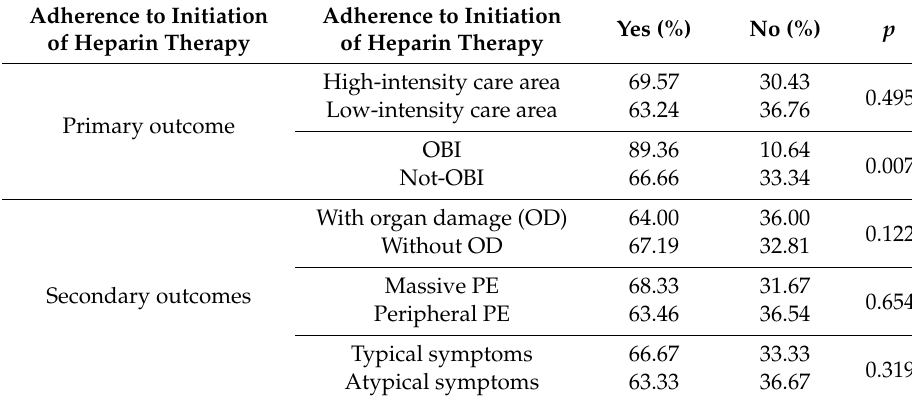
Table 3. Adherence to initiation of heparin therapy. At the top, the analytic subgroups for the primary outcome. Below, the subgroups analyzed in the secondary